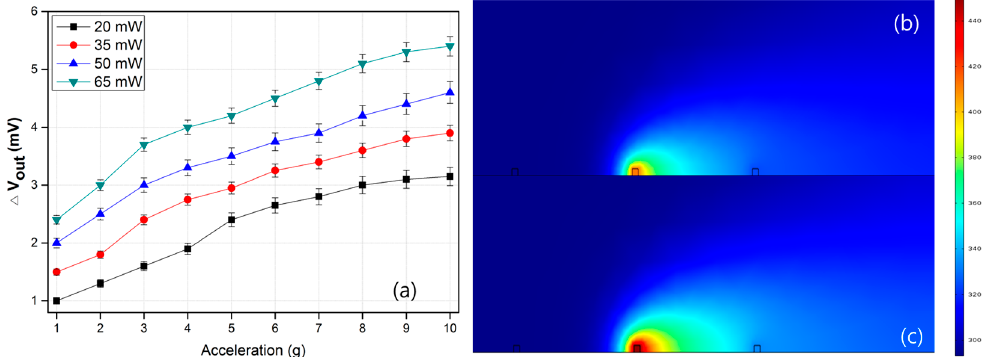
Figure 4. ( a ) The output voltage of the accelerometer as a function of acceleration with respect to the applied heater power and simulation results at a heater temperature of ( b ) 400 K and ( c ) 450 K (acceleration of 1 g and atmospheric pressure).